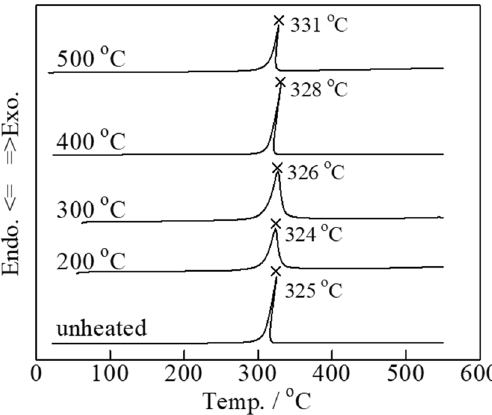
Figure 7. DSC curves of carbon black (2 wt%) mixed with Tl 2 O 3 ‒ 95 wt%Bi 2 O 3 and either left unheated or heat-treated at 200, 300, 400, and 500 °C for 2 h.